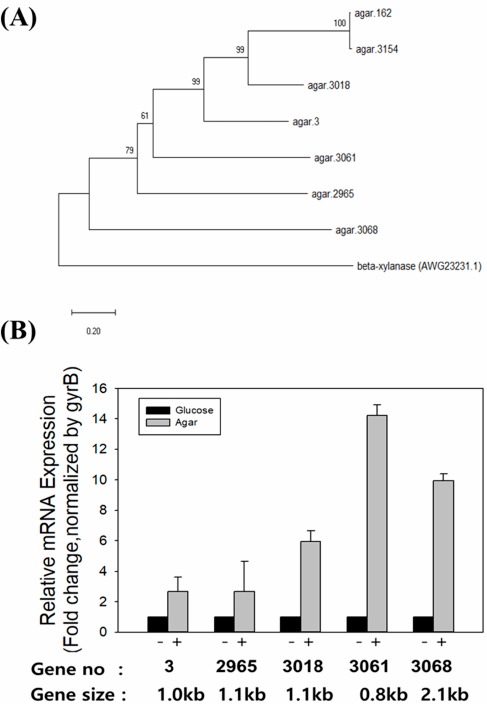
Figure 2. Phylogenetic tree of the seven putative agarases encoded in F. faecale WV33 T genome and mRNA expression analysis of five of them. ( A ) A multiple alignment performed with ClustalW was used for the construction of a phylogenetic tree through the neighbor-joining method using MEGA- X. Scale bar indicates 0.2 amino acid substitutions per site. Numbers at nodes indicate bootstrap percentages (from 1000 bootstrap replicates). Beta-xylanase of F. faecale WV33 T (AWG23231.1) was used as an outgroup to root the tree. ( B ) After F. faecale WV33 T was grown in 100 mL flasks containing 1 g/L sliced solidified agar as carbon source, mRNA expression levels of five putative agarase genes were determined via RT-qPCR. Relative mRNA expression was normalized based on that of the housekeeping gyrB gene (as a control). Bars represent the mean, whereas the error bars represent the standard deviation. Experiments were performed in biological triplicates ( n = 3).